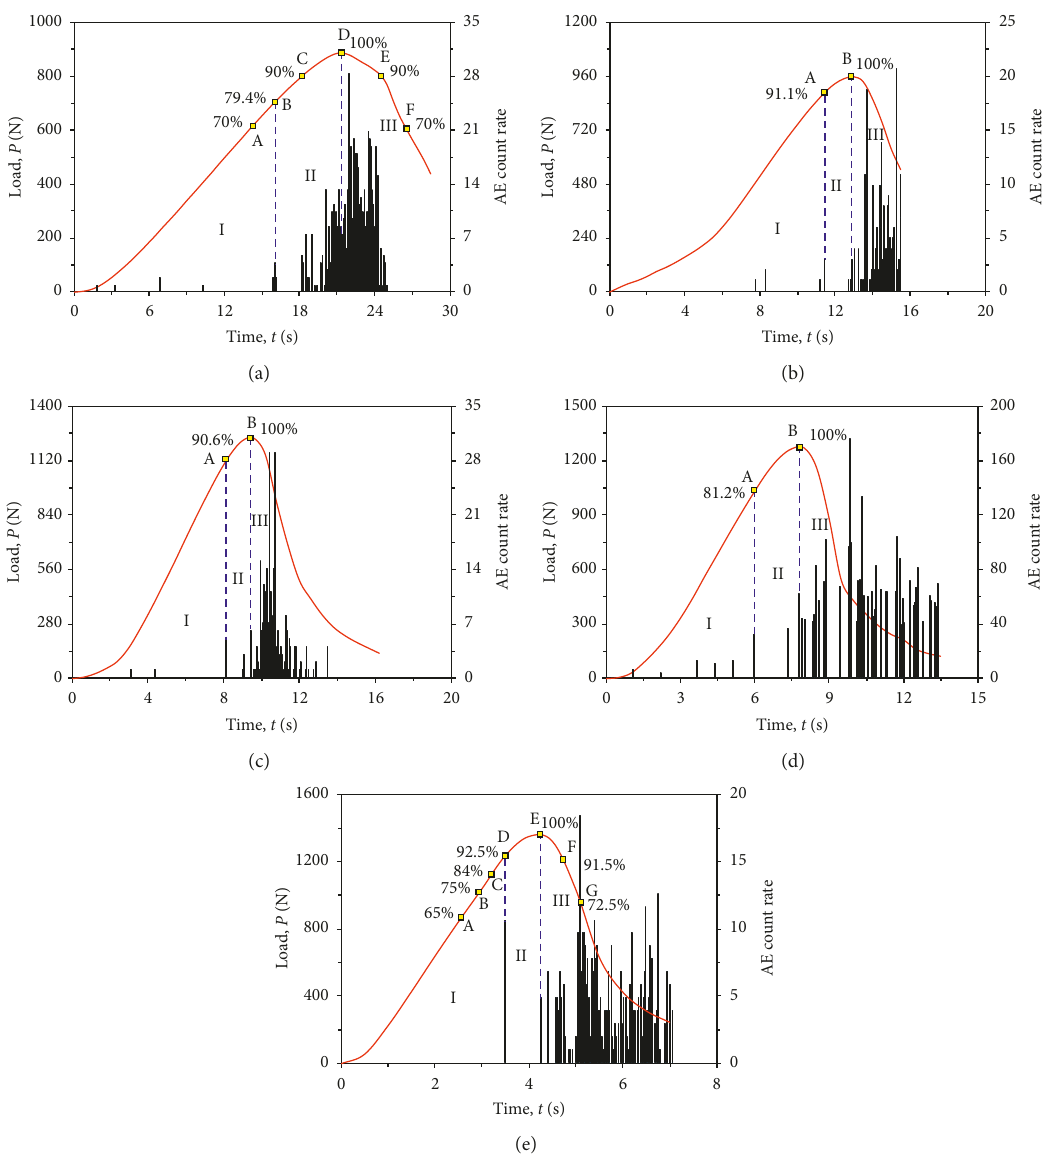
Figure 6: Typical variation in load and AE count rate with time for TPB tests under different loading rates: (a) 0.6mm/min, (b) 1.0 mm/min, (c) 1.4mm/min, (d) 1.8mm/min, and (e) 3.0 mm/min. I, II, and III represent elastic stage, damage stage, and postpeak stage,